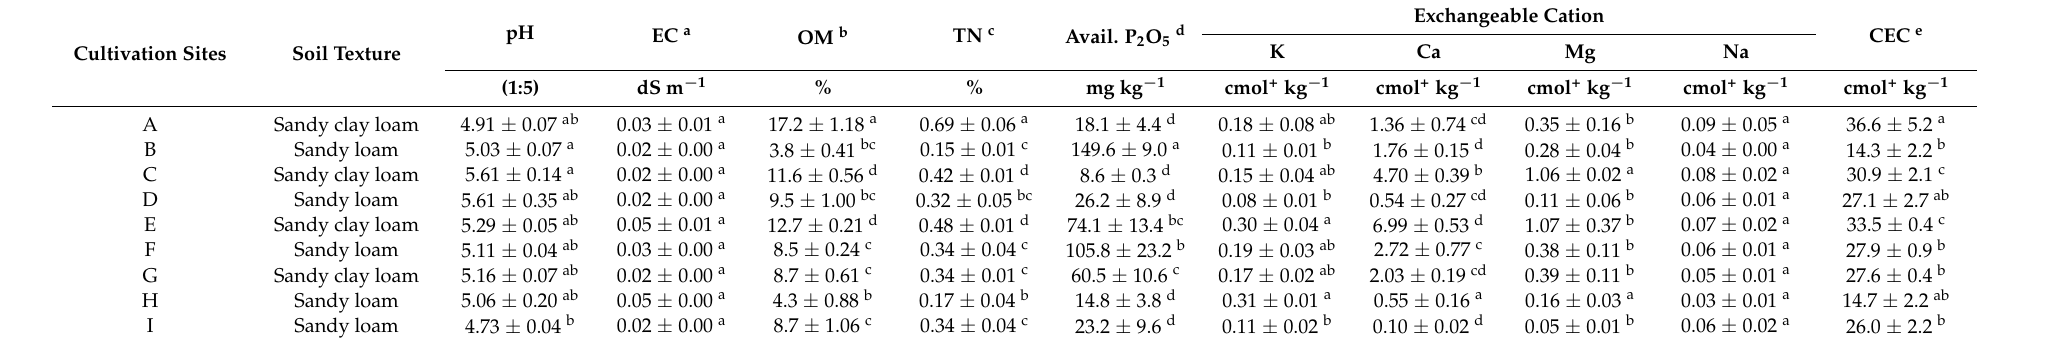
Table 2. Soil chemical properties of the samples from 9 different cultivation sites of